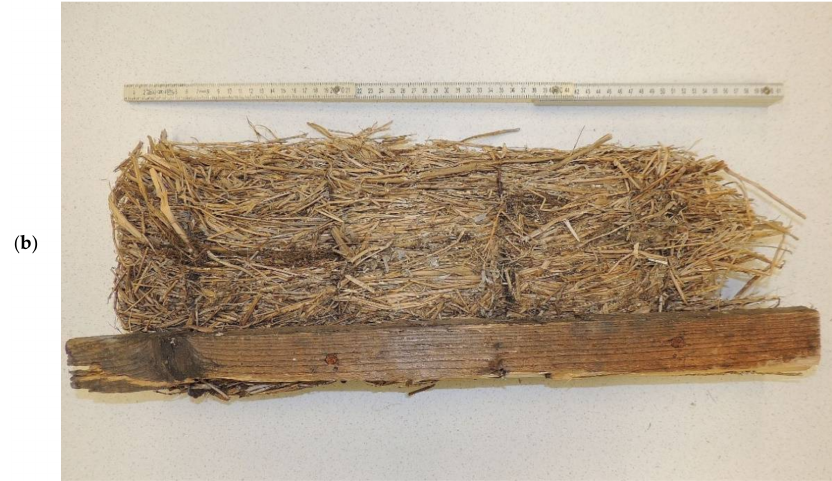
Figure 4. The finding condition of the SOLOMIT panel sample: ( a ) outer side, below, and ( b ) inner side with part of the fastening lath.